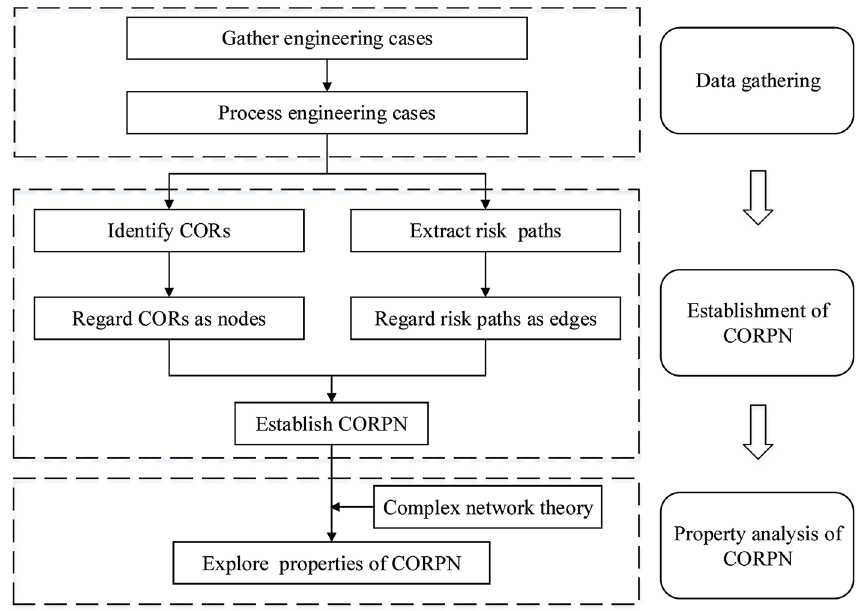
Figure 1. The flowchart of